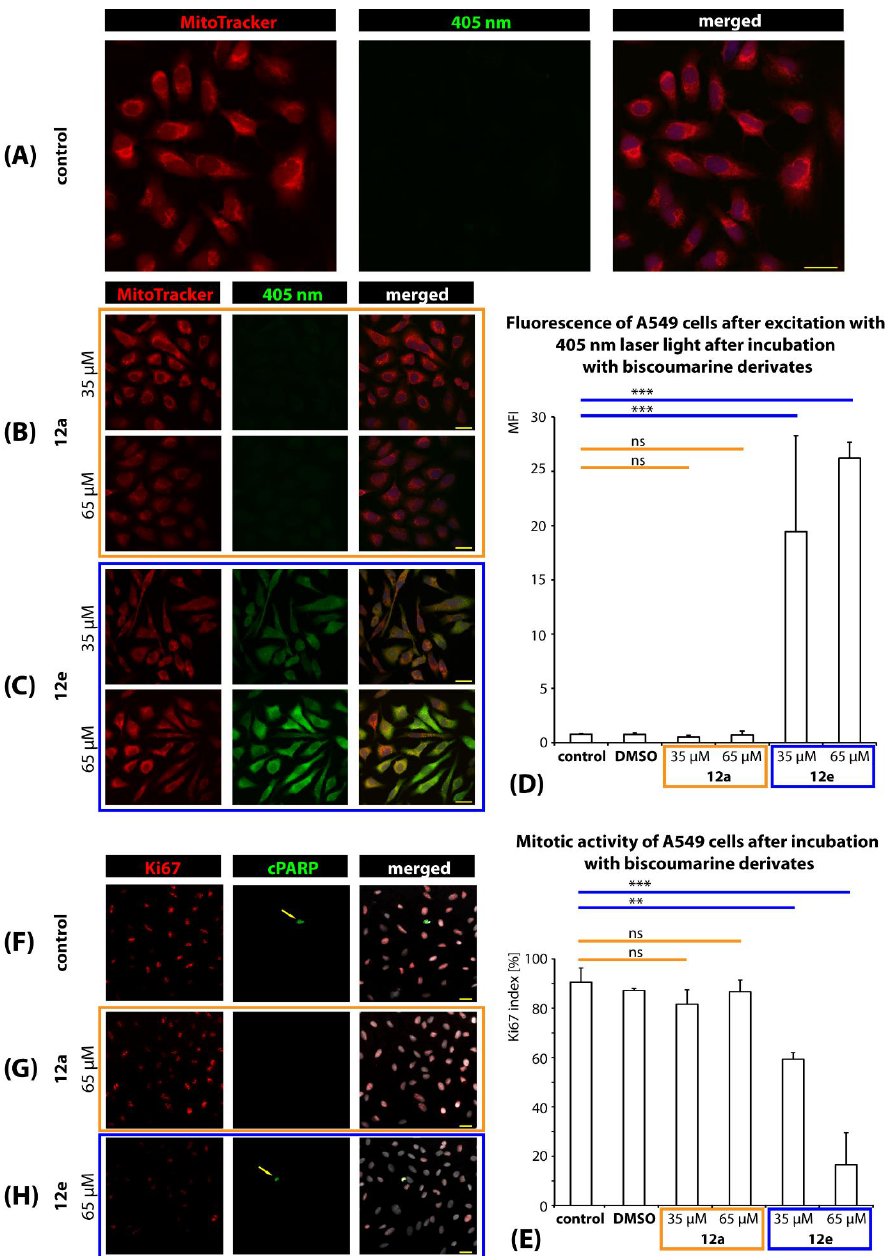
Figure 7. Intracellular localization of derivatives 12a as representative of 12a – d for comparison with 12e and effect of derivatives 12a and 12e on the mitotic activity of A549 cells. Representative microphotographs of A549 cells cultivated in a normal medium without derivatives as control ( A ) or co-cultivated with derivatives 12a ( B ) and 12e ( C ), respectively. For the visualization of the cell bodies and nuclei, MitoTracker (red), and Draq5 (blue) stains were used. The studied derivatives would be expected to emit light upon excitation with 405 nm laser light (green). The fluorescence of the A549 cells after co-cultivation with the studied derivatives was quantified with densitometric analysis ( D ). The effect of the derivatives on mitotic activity was quantified as a Ki67 index ( E ) reflecting the percentage of the dividing cells. Representative microphotographs of control ( F ) and cells co- cultivated with derivatives 12a ( G ) and 12e ( H ), respectively. Anti-Ki67 antibody labels the nuclei of proliferating cells (red), anti-cleaved PARP is used for the visualization of apoptotic cells (green). Examples of apoptotic cells are highlighted with yellow arrows. Nuclei are stained with Draq5 (gray). Scale bar = 25 µ m. Statistical significance for multiple comparisons: ns, nonsignificant; ** p < 0.01; *** p <